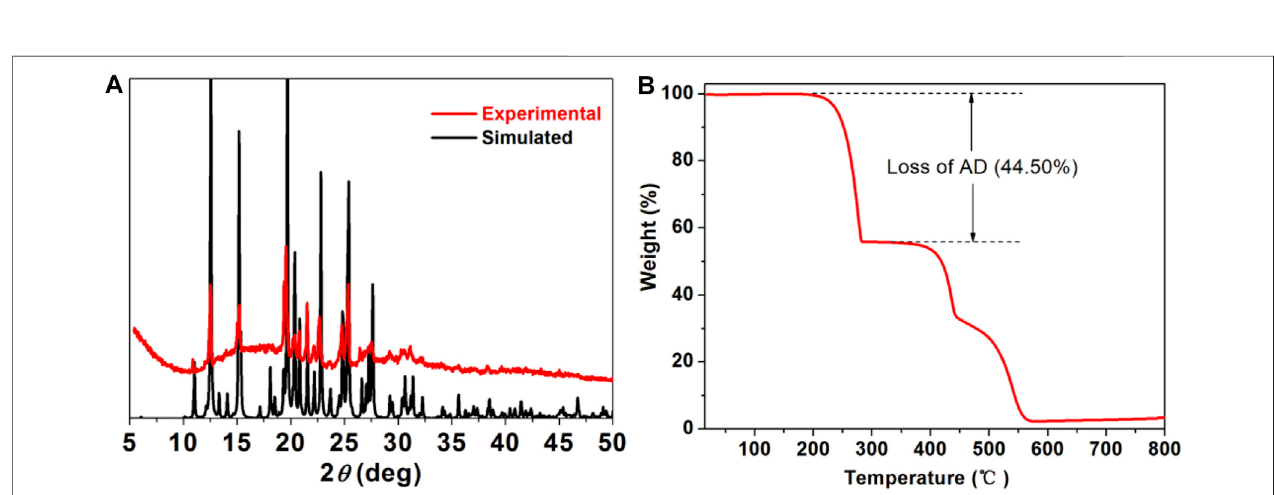
FIGURE 2 | (A) PXRD patterns of simulated (black) and as synthesized DCPA-AD (red). (B) Thermo gravimetric analysis curve of DCPA-AD .